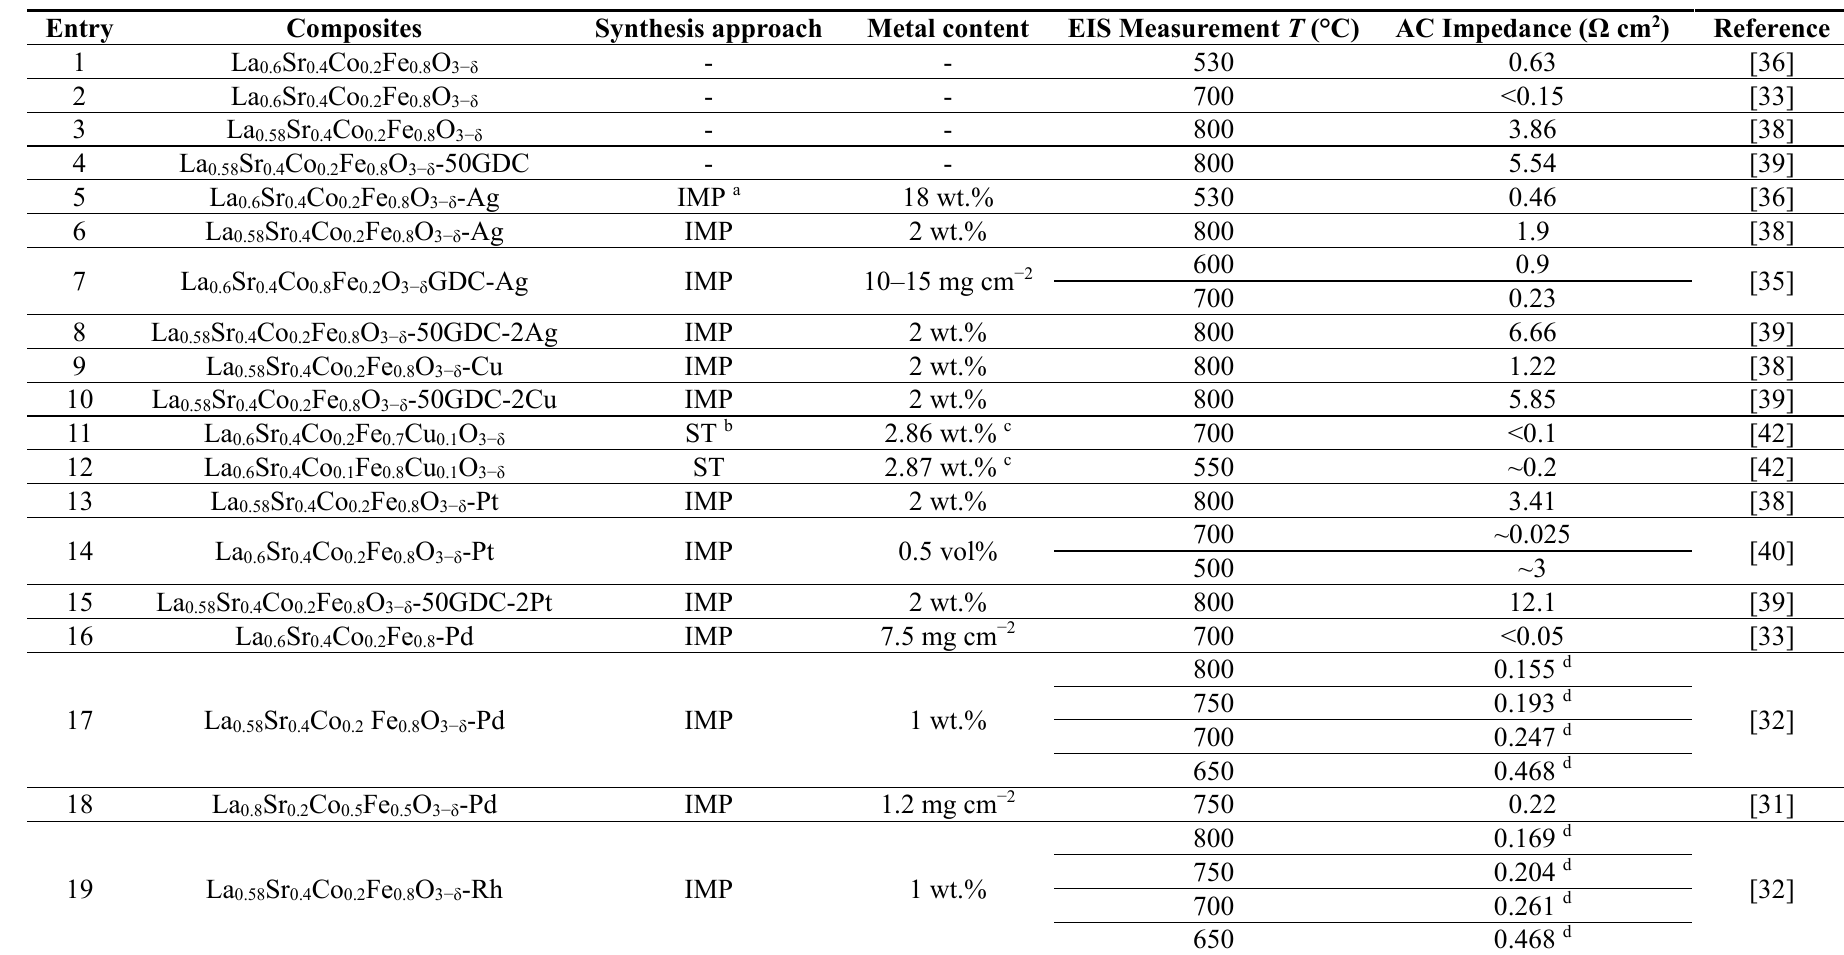
Table 1. Summary of recent results on metal- substituted LSCF perovskites: synthesis approach, metal content and AC impedance values measured at different